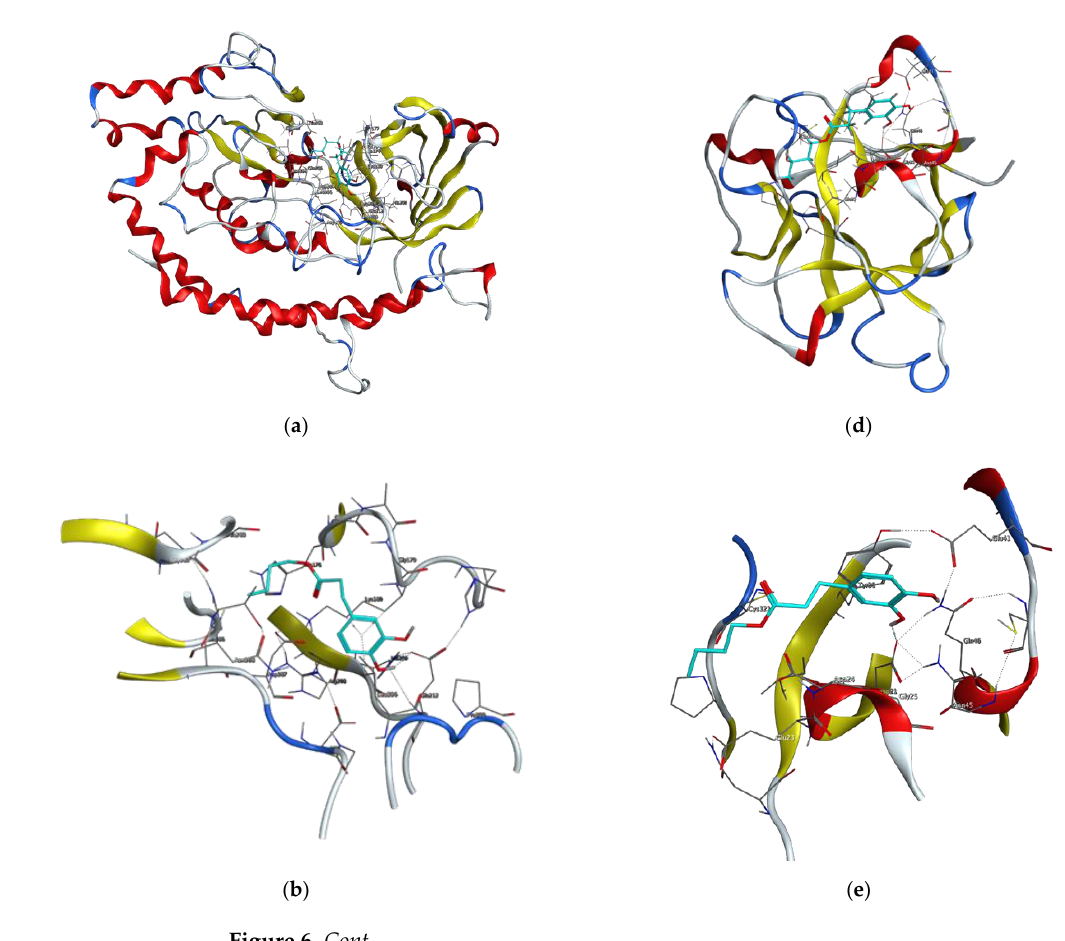
Figure 5. Visualizations of docking analysis of glutamine-fructose-6-phosphate transaminase (GFAT) binding with butyl dihydrocaffeate: ( a , b ) 3D visualizations, ( c ) 2D binding interactions, and 14- α sterol demethylase B binding with butyl dihydrocaffeate: ( d , e ) 3D visualizations, ( f ) 2D binding interactions.